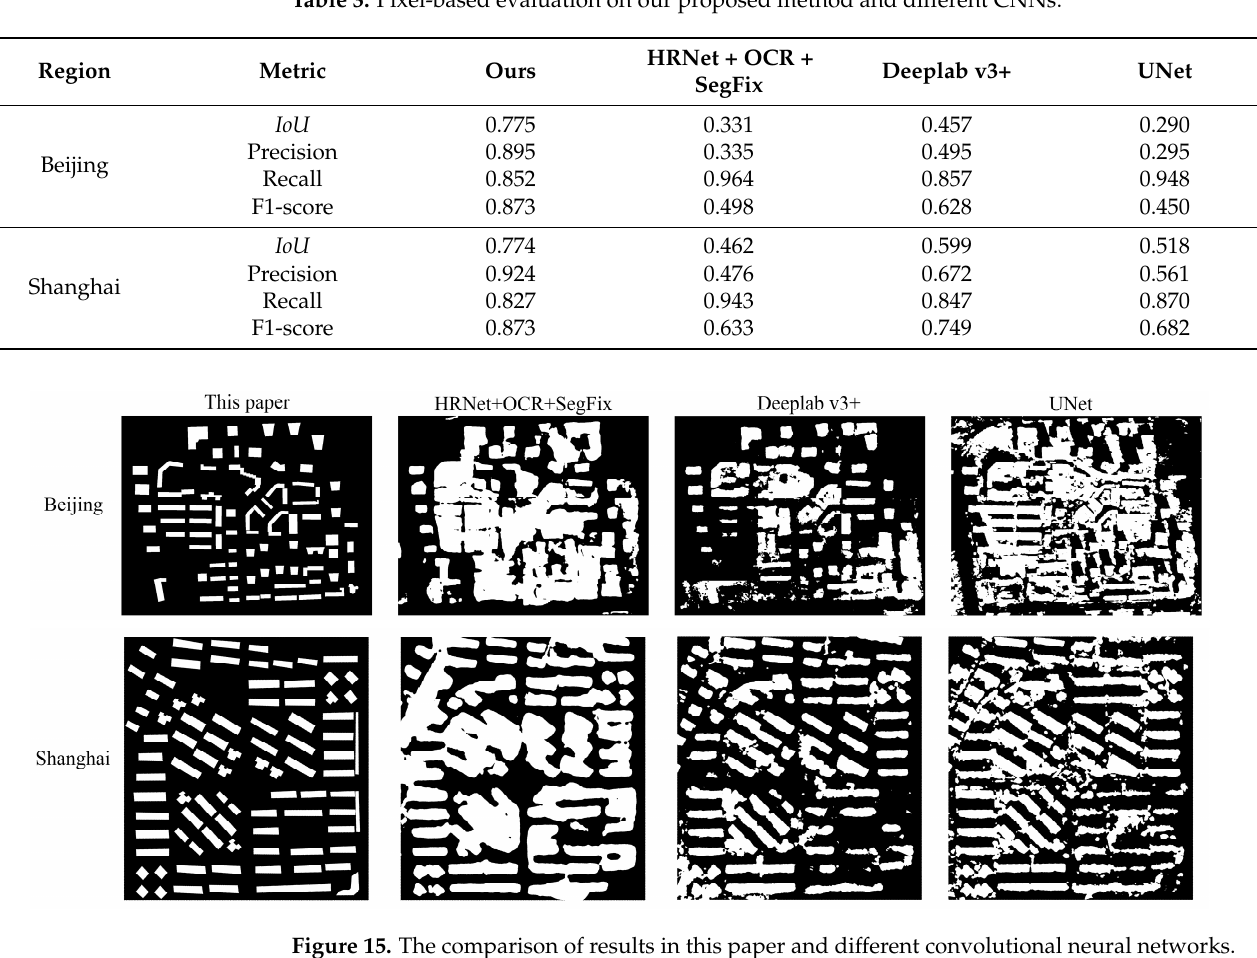
Table 3. Pixel-based evaluation on our proposed method and different CNNs.